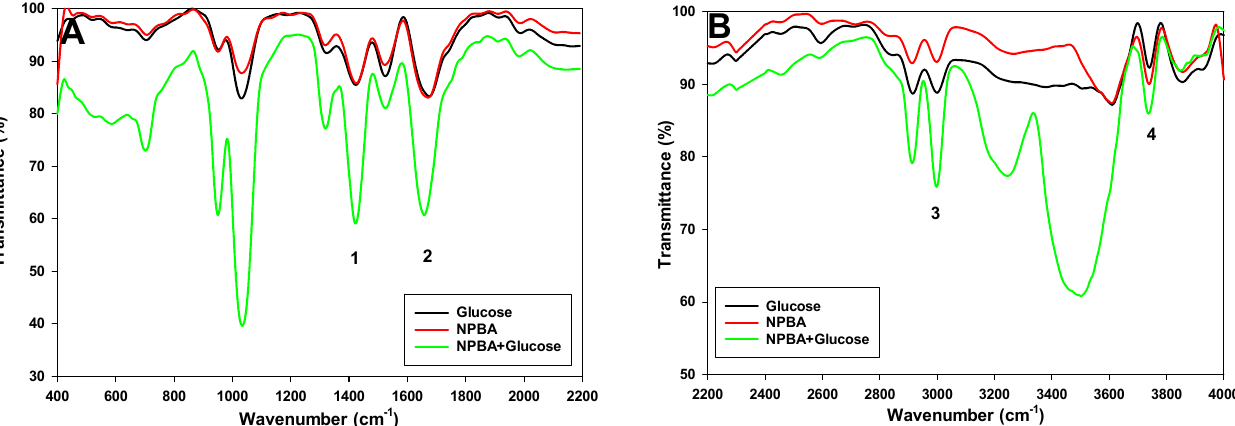
Figure 3. IR spectra of glucose, NPBA, and their mixture (complex): ( A ) IR spectra from 400 to 2200 cm − 1 ; ( B ) IR spectrum from 2200 to 4000 cm − 1 .